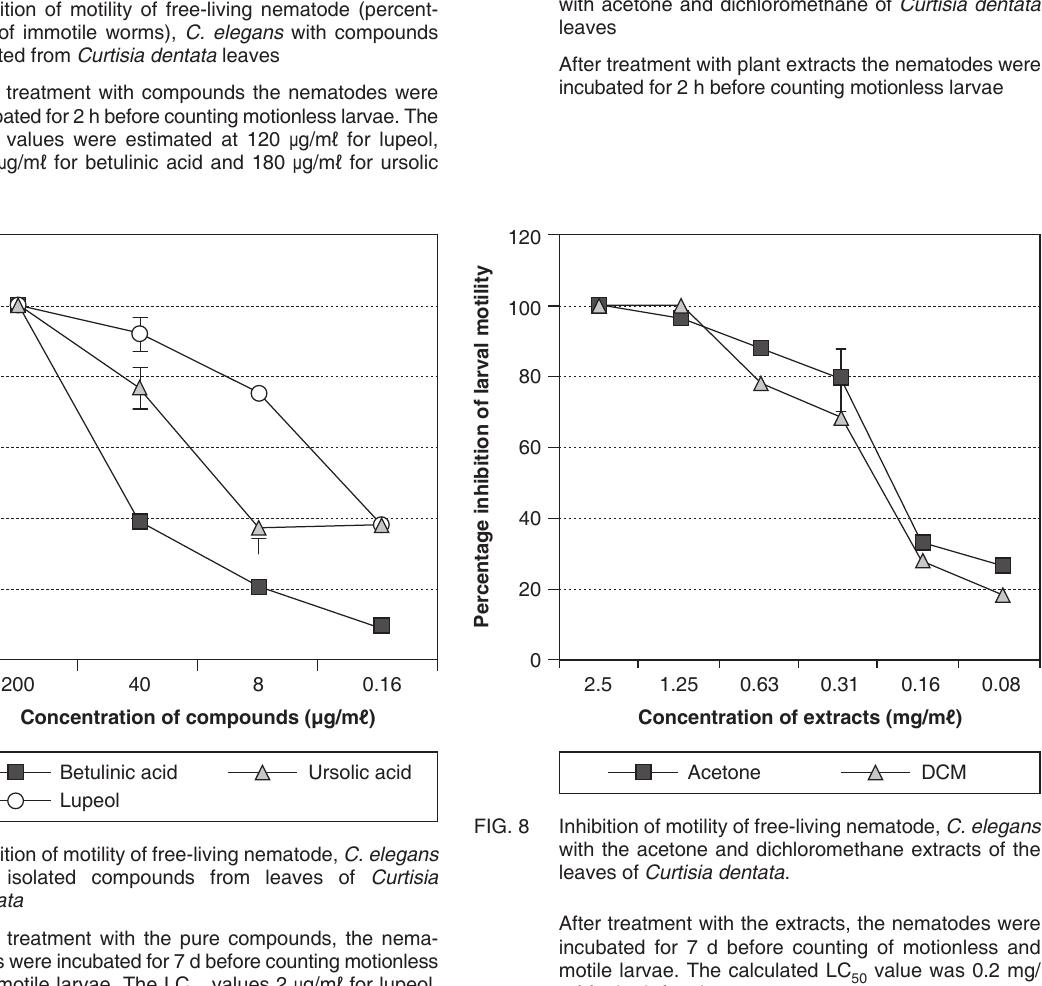
FIG. 6 Inhibition of motility of free-living nematode, C. elegans